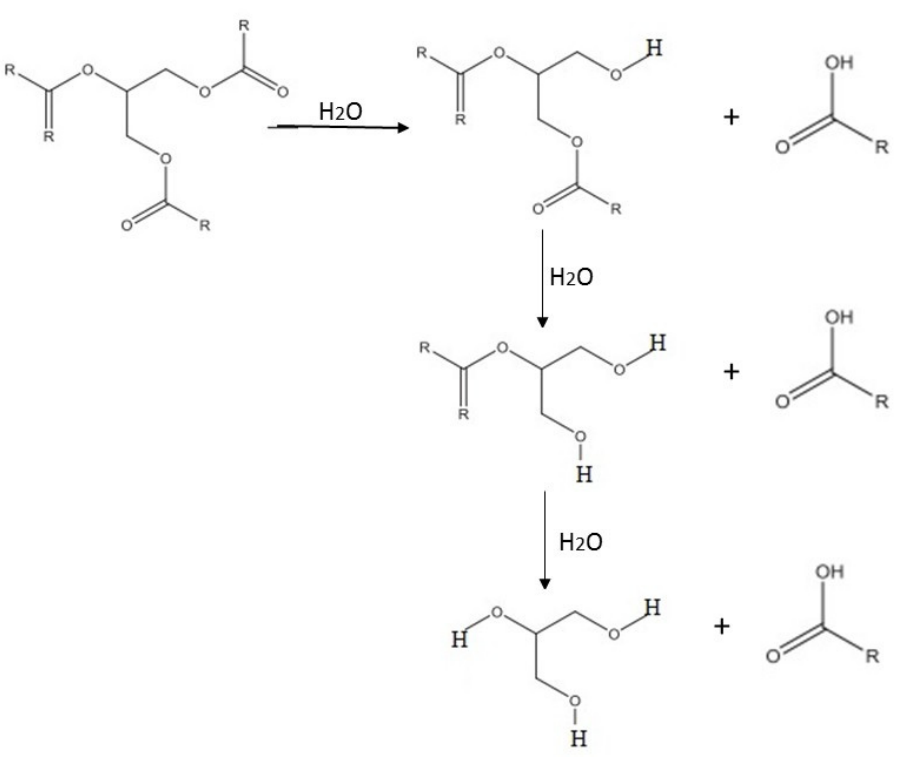
Scheme 4. Reaction sequence of the hydrolysis reaction from triglyceride.